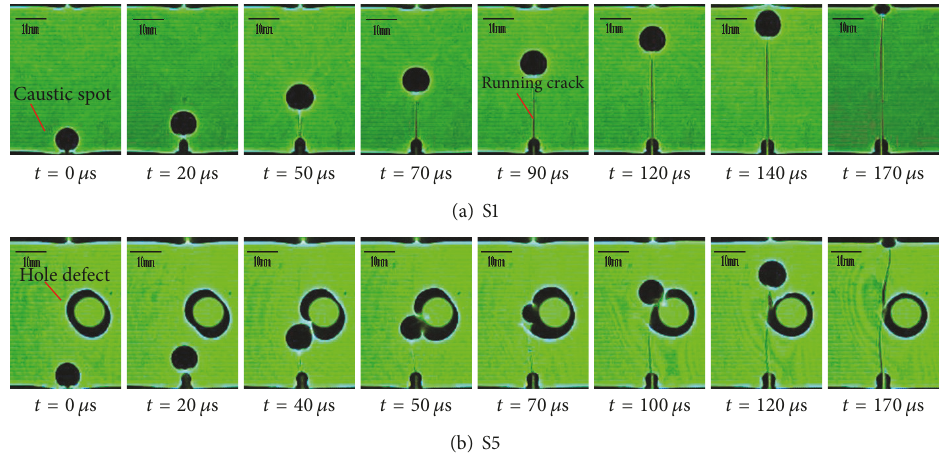
Figure 6: Caustic photographs of running cracks during propagation.